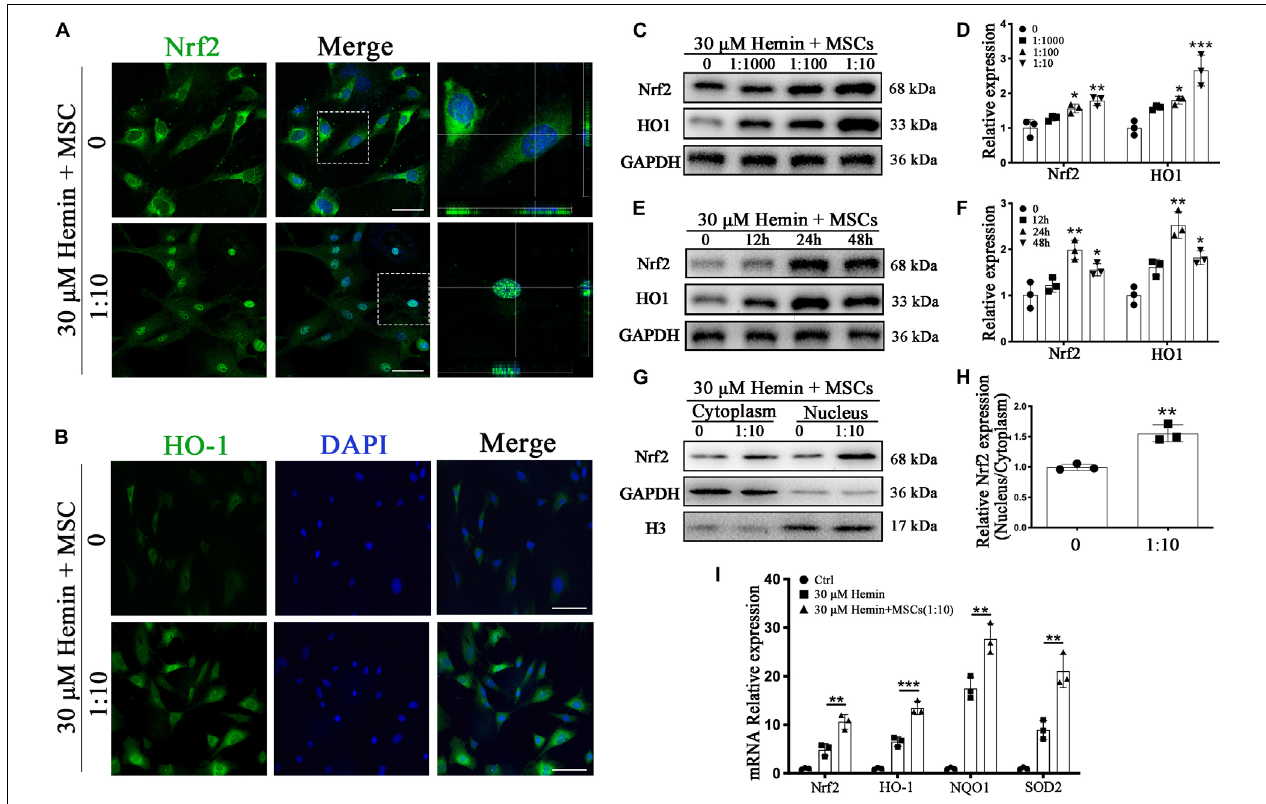
FIGURE 5 | BM-MSCs coculture induced Nrf2 upregulation and promoted its nuclear translocation in astrocytes. (A) Immunofluorescence staining of astrocytes with Nrf2 (green). The cell nuclei were counterstained with DAPI (blue). BM-MSCs coculture treatment triggered Nrf2 nuclear translocation in astrocytes exposure to 30 µ M hemin. Bar = 25 µ m. (B) Immunofluorescence staining of astrocytes with HO-1 (green). The cell nuclei were counterstained with DAPI (blue). BM-MSCs coculture treatment increased HO-1 expression in astrocytes exposure to 30 µ M hemin. Bar = 25 µ m. (C–F) Western blotting analysis of Nrf2 and HO-1 expression in astrocytes exposure to 30 µ M hemin, cocultured with BM-MSCs for indicated times and doses. (G) Western blotting analysis of cytoplasmic and nucleus extraction samples from astrocytes, cocultured with BM-MSCs or not, with Nrf2 antibody. GAPDH and H3 were used as a loading control for cytoplasmic and nucleus protein, respectively. (H) The histogram showing the results of densitometric analysis of nucleus/cytoplasmic Nrf2 expression in astrocytes cocultured with BM-MSCs or not. (I) mRNA expression of Nrf2, HO-1, NQO1, SOD2 in astrocytes with or without BM-MSCs coculture exposed to 30 µ M hemin for 24 h. The relative expression of the mRNA was normalized to control. The results of densitometric analysis of the bands were plotted into histogram. All data are displayed as means ± SD ( n = 3). The difference between groups was analyzed using One-way ANOVA test. Comparisons between two groups were made by Student’s t -test. * p < 0.05, ** p < 0.01, *** p < 0.001, compared with control (0 h or 0 µ M).